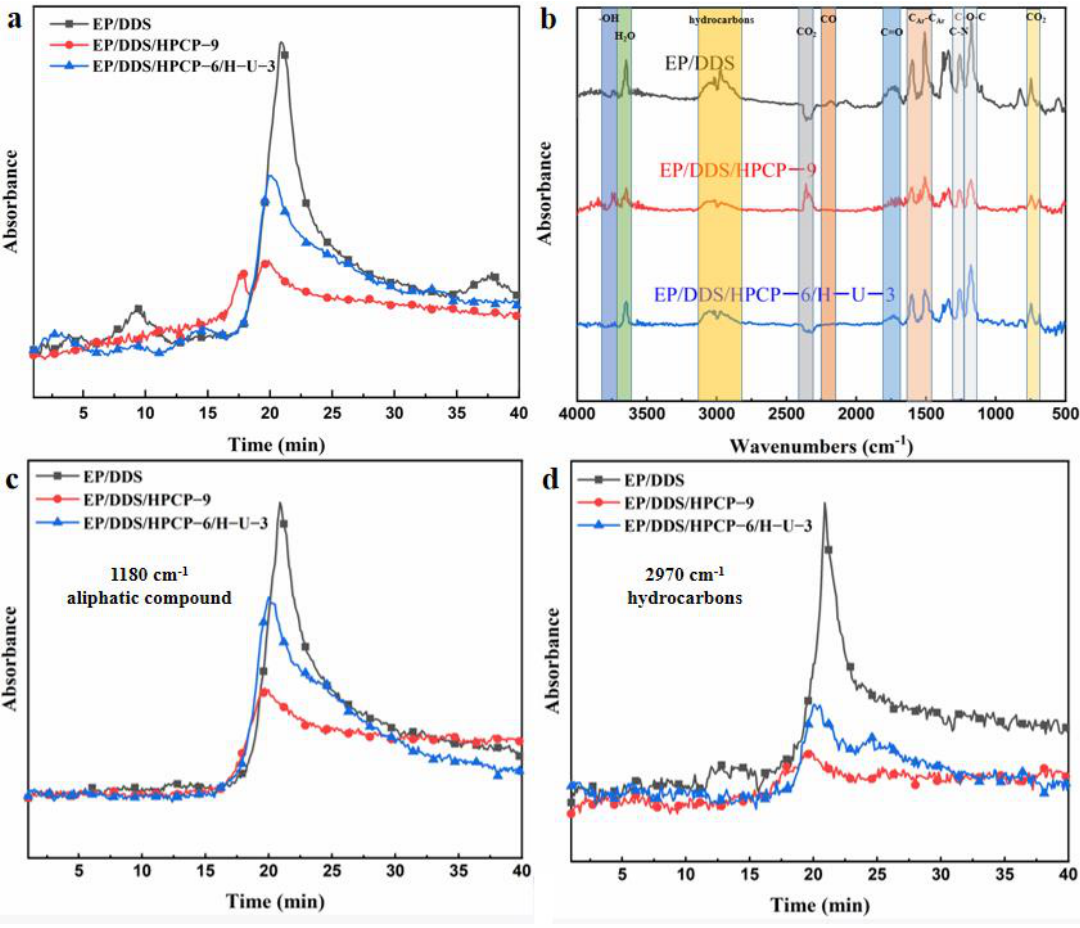
Figure 12. TG-IR spectra of decomposition products of EP composites: total absorbance ( a ), T max ( b ), aliphatic compound ( c ), and hydrocarbons ( d ).